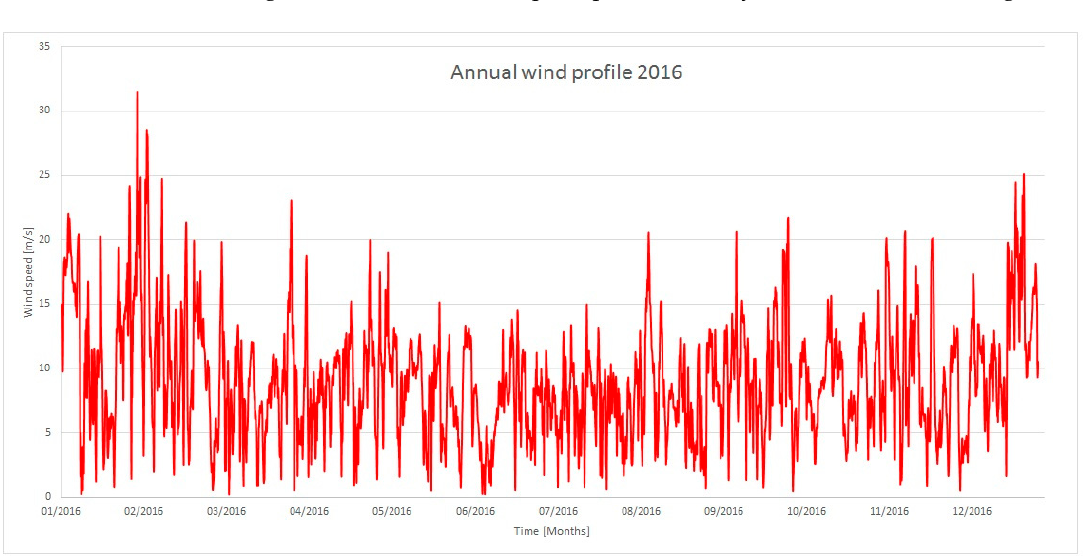
Figure 2: k = 2.23 which is the shape parameter, and A = 8.57 m/s which is the scale parameter. Both parameters stand for the characteristic mean wind